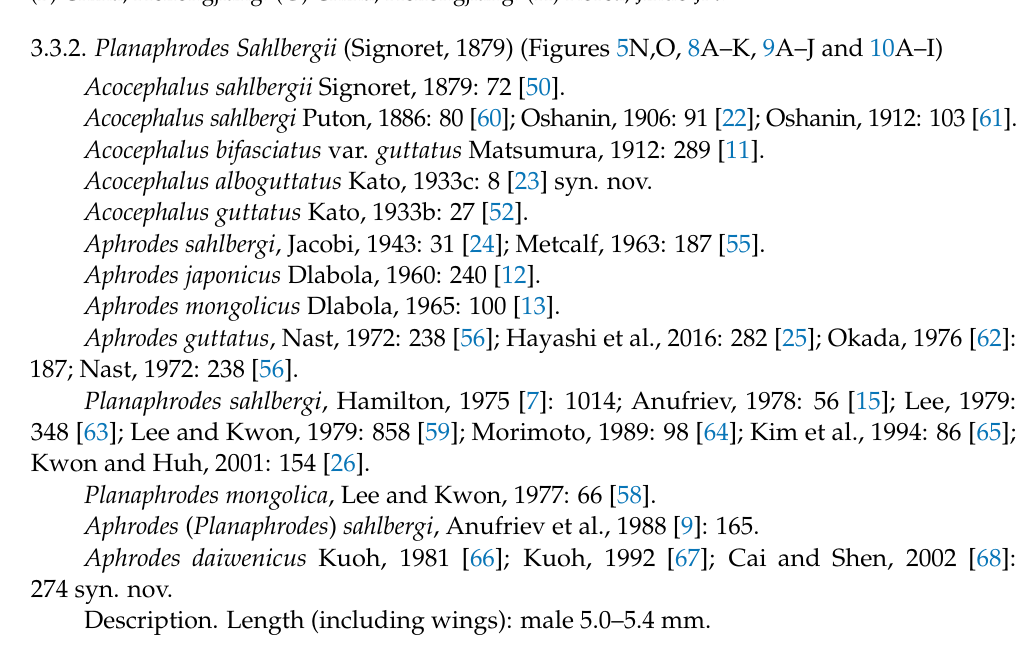
Figure 7. ( A – H ) Planaphrodes nigricans , aedeagus in lateral and caudal view. ( A ) Korea, Hallasan JJ. ( B ) Korea, Deogsungsan CN. ( C ) Korea, Jindo JN. ( D ) Korea, Wando JN. ( E ) Korea, Palgongsan GB. ( F ) China, Heilongjiang. ( G ) China, Heilongjiang. ( H ) Korea, Jindo JN.